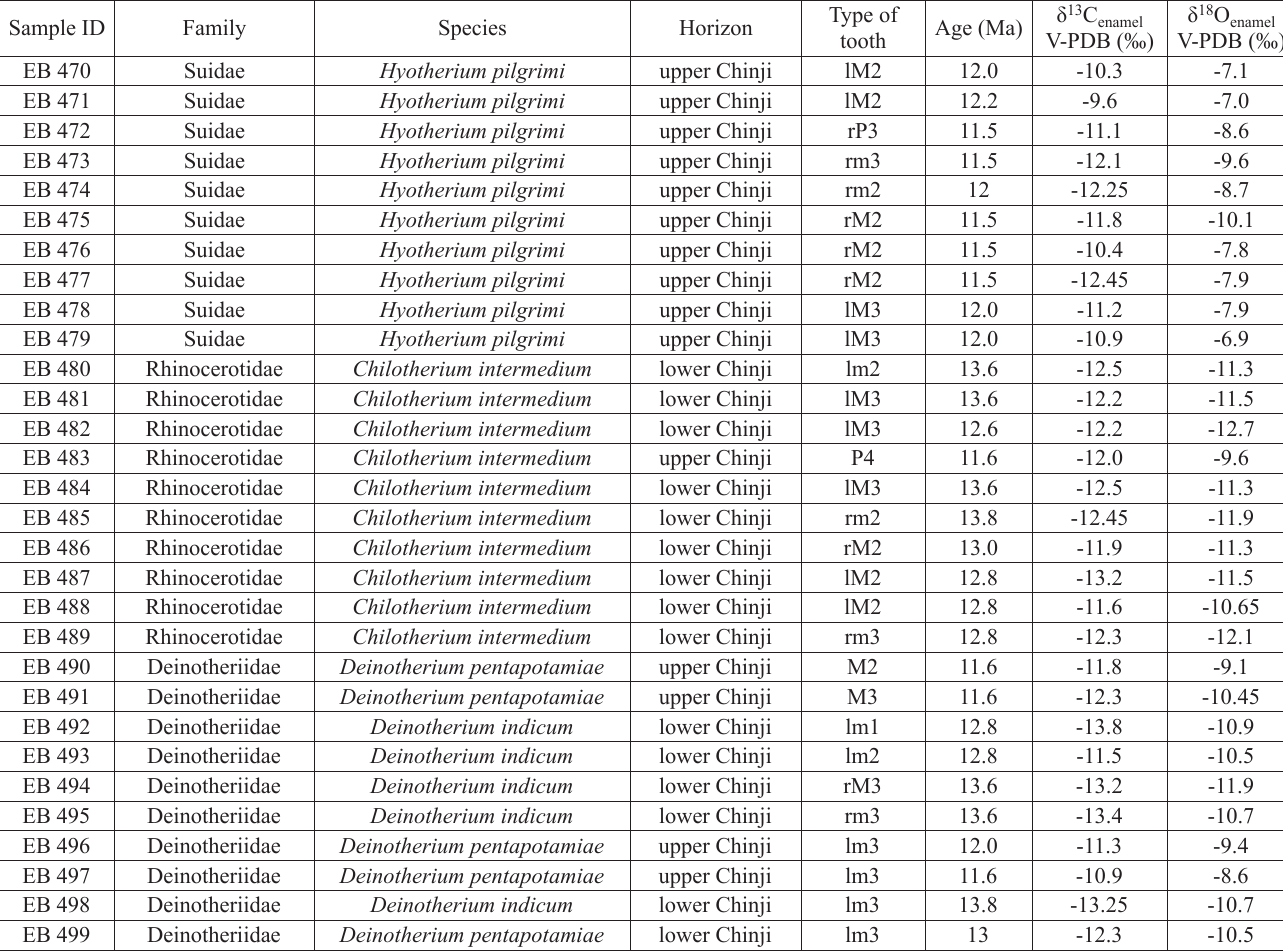
Table­1.­δ 13 C enamel ­and­δ 18 O enamel values for thirty enamel samples of fossil mammals from the middle Miocene Siwaliks of Pakistan. The ages of the samples have been calibrated according to Gradstein et al. (2012). Abbreviations: l, left; M/m, upper/lower molar; PM, upper premolar; r, right; V-PDB, Vienna Pee Dee